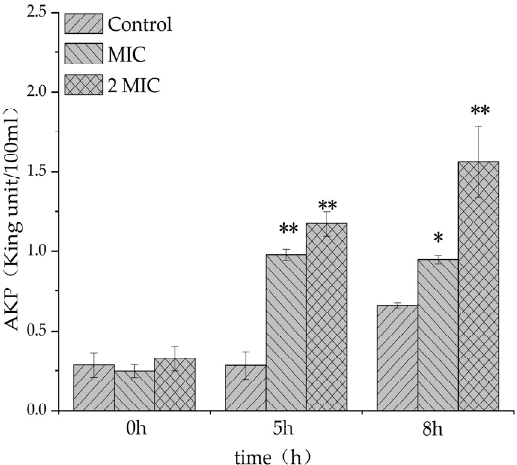
Figure 4. Effect of MA on the leakage of alkaline phosphatase from S. aureus. *: Compared with the control group, the difference is significant ( p < 0.05); **: Compared with the control group, the difference is extremely significant ( p < 0.01).